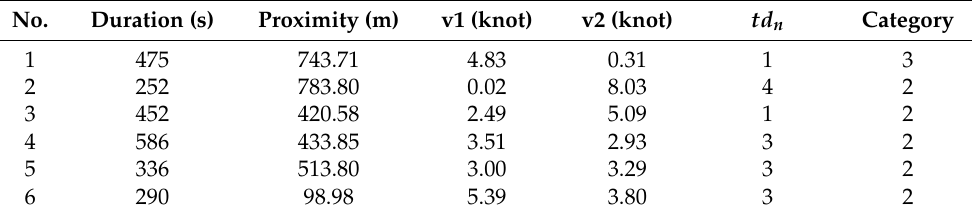
Table 8. Fixed threshold results for non-traffic intensive, low-suspicious